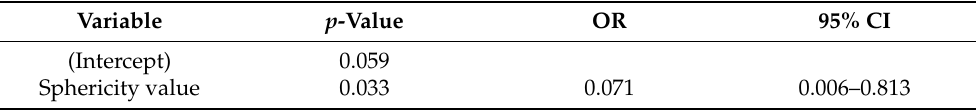
Table 4. The result of logistic regression and split data validation for predicting the micropapillary subtype (area under the curve (AUC): 0.603, 97% CI: 0.489–0.716). Variable p -Value